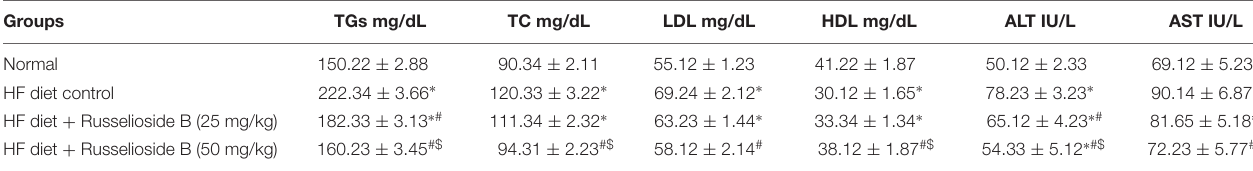
TABLE 4 | Effect of russelioside B (25 and 50 mg/kg) on serum lipid profile and liver enzyme activities in rats fed with high fat diet.